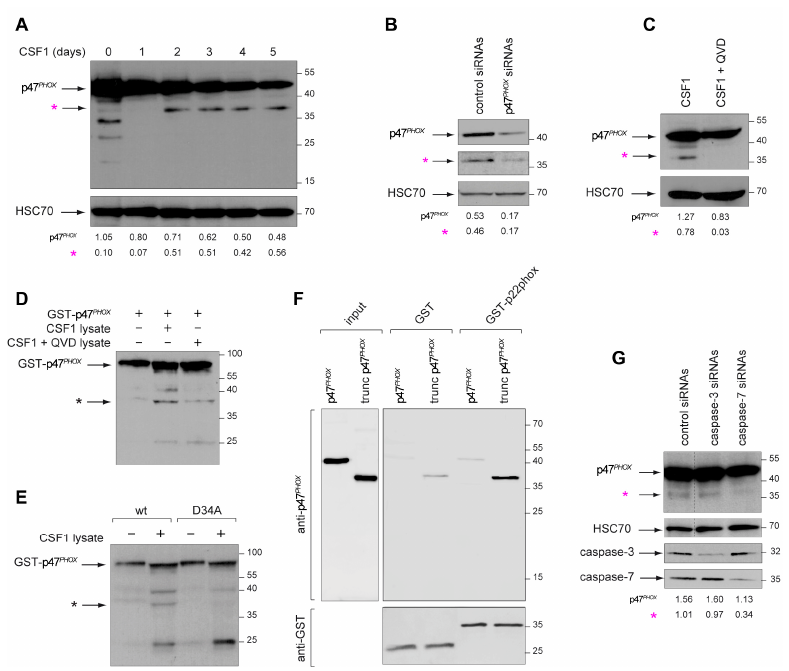
Figure 6. Caspase-mediated cleavage of p47 PHOX generates an active NOX2 complex. ( A )